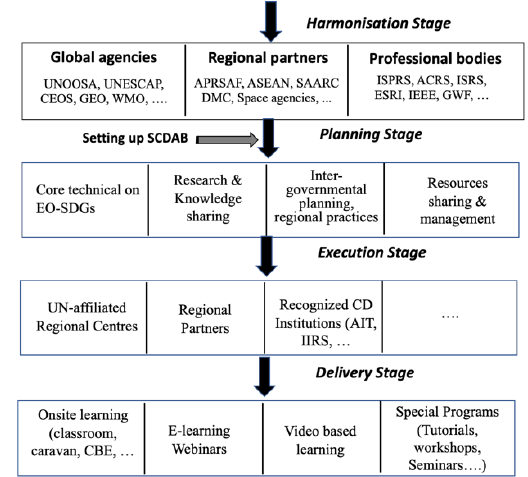
Figure 5 . A conceptual framework for coordinated CD (modified from Kumar et al.